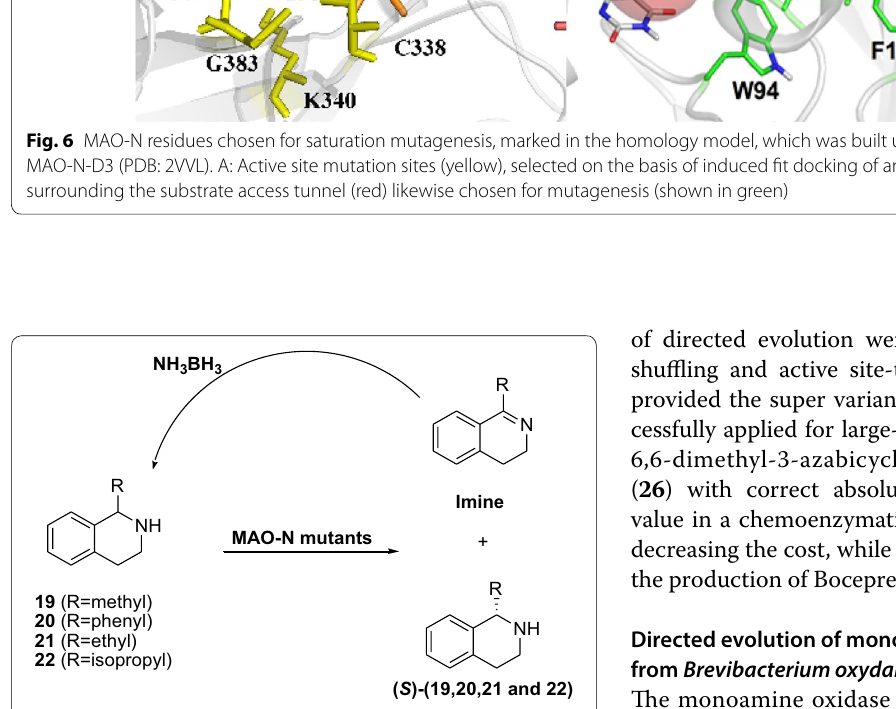
Fig. 7 Deracemization of racemates 19 , 20 , 21, and 22 by employing a sequence of enantioselective oxidations with MAO-N mutants and non-selective reduction with NH 3 BH 3